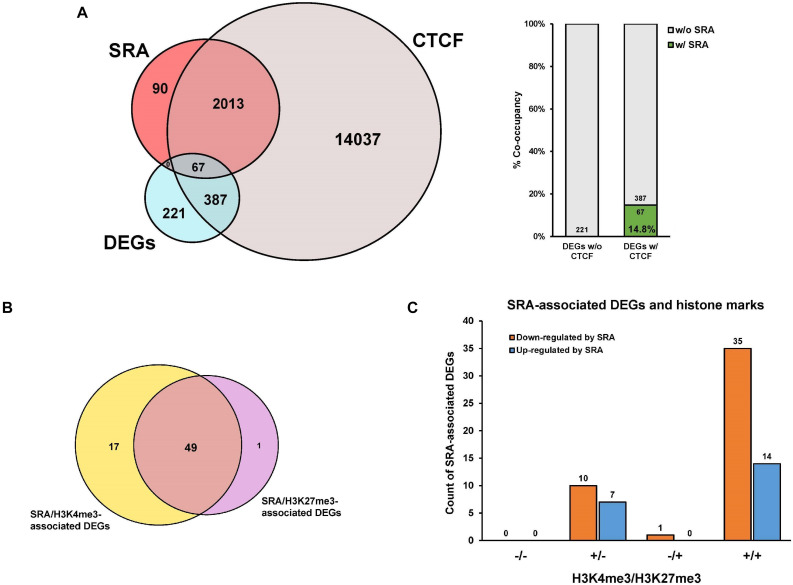
Genes differentially expressed by SRA knockdown are occupied by SRA, CTCF and histone marks at the chromatin level. Publicly available ChIP-seq data for CTCF, H3K4me3, and H3K27me3 were derived from the ENCODE project. (A) Genes transcriptionally regulated by SRA and containing SRA binding site tend to associate with CTCF. Numbers of differentially expressed genes (DEGs) were compared with numbers of SRA-associated genes or CTCF-associated genes as shown by the Venn diagram. Percentage of DEGs with both SRA and CTCF occupancy is higher than that without CTCF. (B) A comparison of differentially expressed genes occupied by SRA in association with H3K4me3 or H3K27me3. (C) Genes down-regulated or up-regulated by SRA containing SRA occupancy were grouped into four categories depending on the presence (+) or absence (−) of H3K4me3 or H3K27me3.